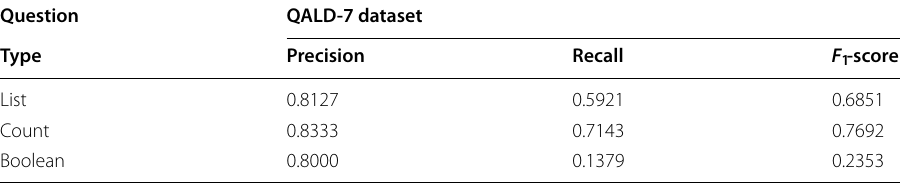
Table 8 Performance of each question type on QALD-7 dataset